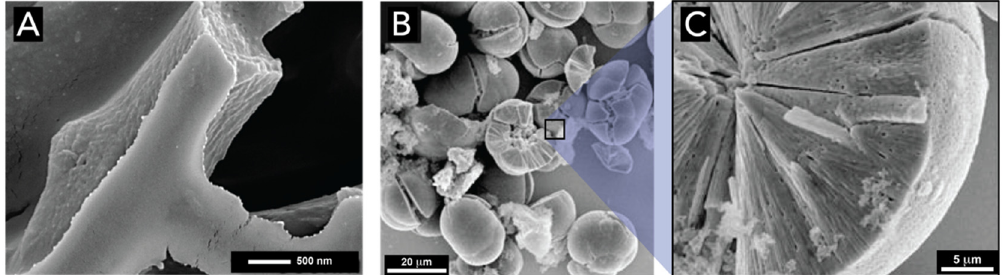
Figure 26. Biomimetic synthesis of titanium dioxide. SEM micrographs of ( A ) TiO 2 product formed by catalysis with purified sponge silicatein filaments and ( B ) titania particles made by diatom silaffins and zoom in ( C ). Scale bars: ( A ) 500 nm, ( B ) 20 µ m, ( C ) 5 µ m. Image A reproduced from [197] with permission from American Chemical Society. Images in B are adapted from [196] with permission from John Wiley and Sons.